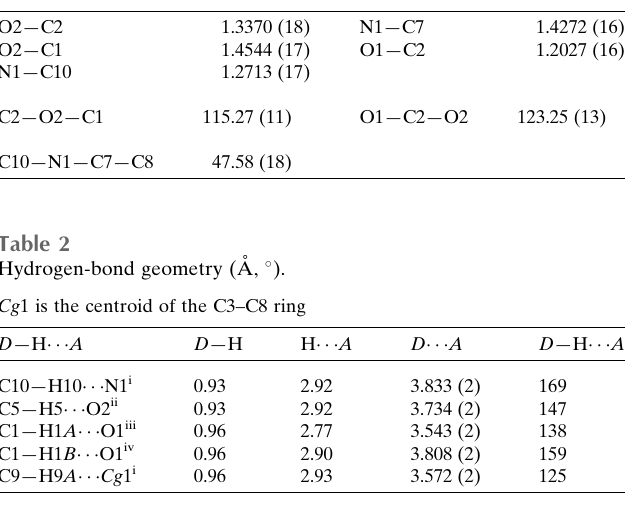
Table 1 Selected geometric parameters (A˚ , (cid:2) ).